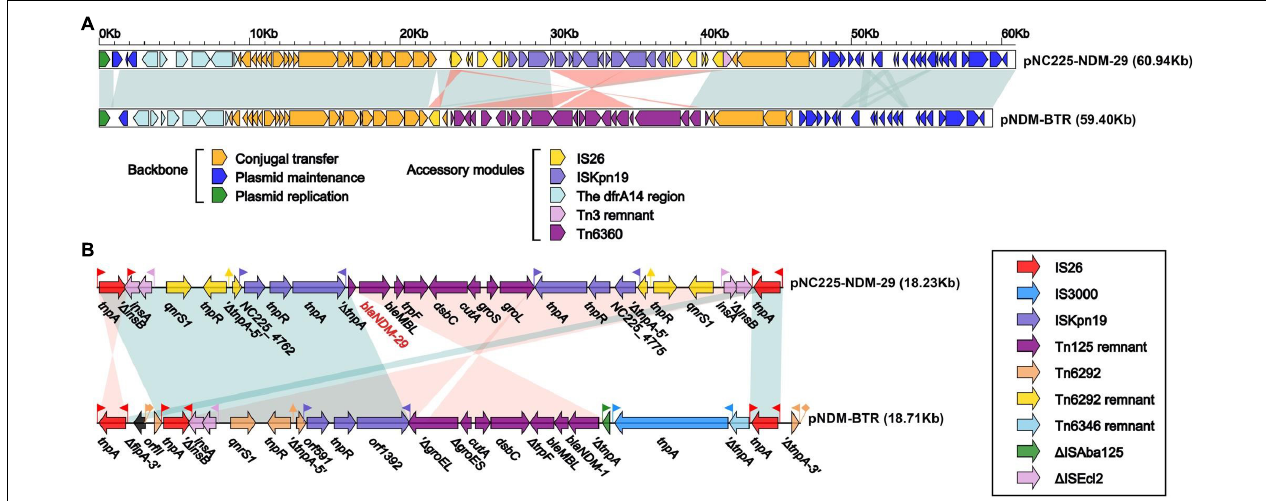
FIGURE 6 | Structure of pNC225-NDM-29 and related transposon. (A) Linear comparison of plasmid pNC225-NDM-29 with the most similar plasmid pNDM-BTR. Genes are denoted by arrows. Genes, mobile elements, and other features are colored based on functional classification. Shading denotes the regions with high homology (95% nucleotide identity). (B) The linear genomic comparison of the drug resistance region in plasmids between pNC225-NDM-29 and pNDM-BTR. The whole region containing main functional areas of pNC225-NDM-29 is located inside two opposite-directed IS26 elements, formatting an IS26-based transposon structured as IS16- (cid:49) ISEcl2-qnrS1-Tn6292 remnant-ISKpn19- bla NDM − 29 -bleMBL-trpF-dsbC-cutA-groS-groL-ISKpn19-Tn6292-remnant-qnrS1- (cid:49)